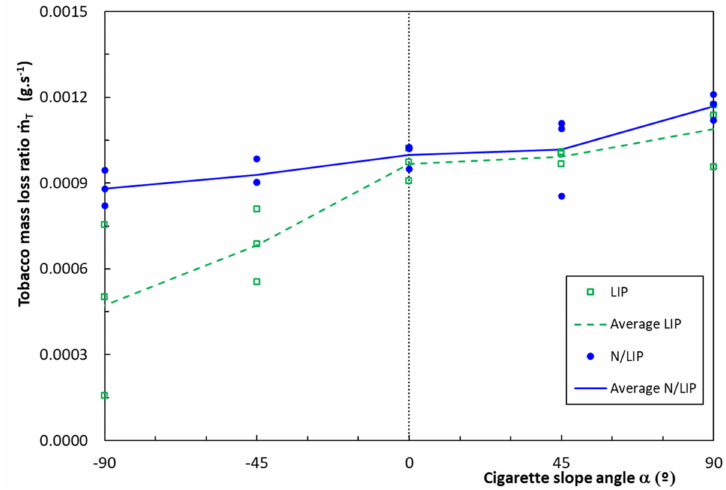
Figure 4. Variation of mass loss ratio with slope angle α of the cigarette for Ignition Propensity (LIP) cigarettes and No Lower Ignition Propensity (N/LIP) cigarettes.